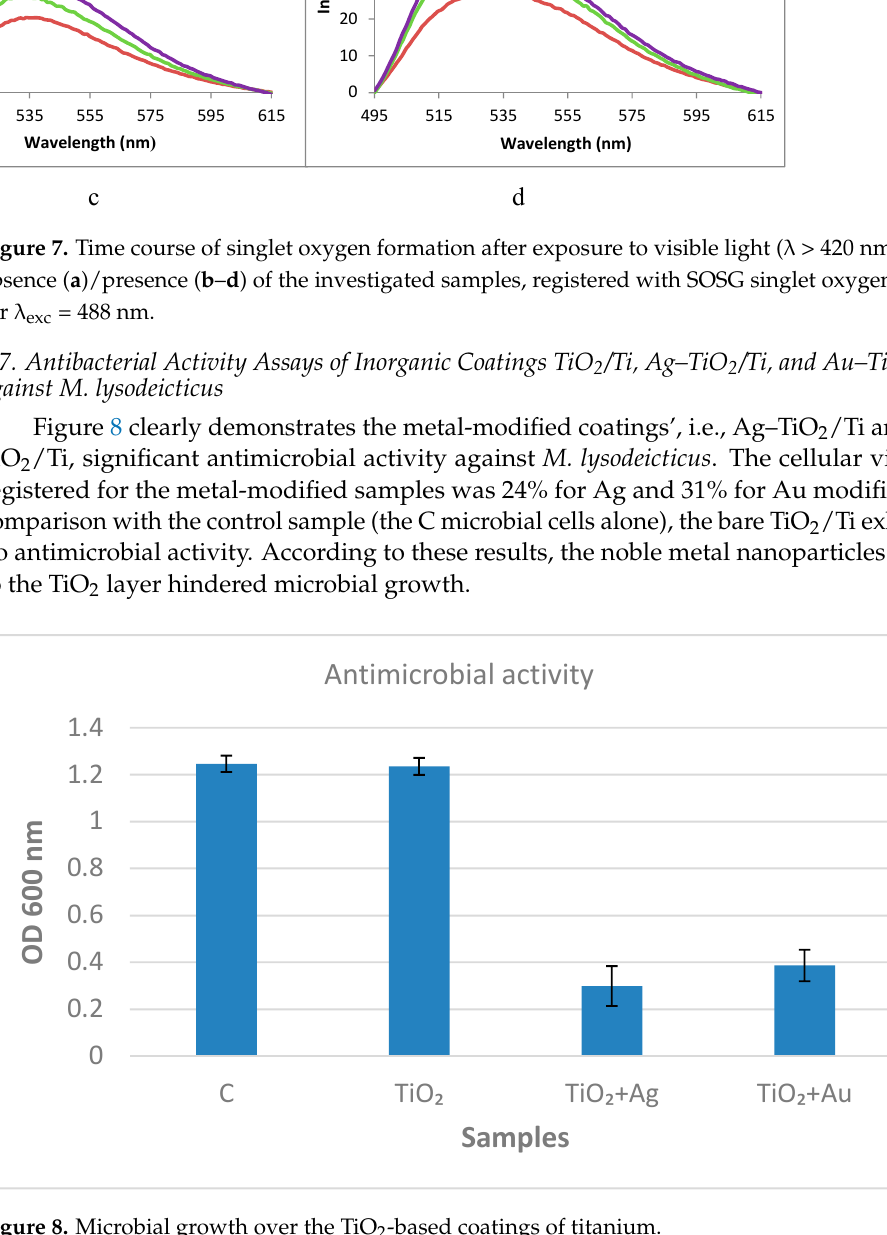
Figure 9. Activity of lysozyme (free and loaded on inorganic coatings) against M. lysodeicticus . The loaded lysozyme appears to have a slower reactivity than the free enzyme, but this is significant and clearly evidenced after 24 h (as compared with the blank test carried out with the M. lysodeikticus cell suspension alone). Based on Figure 9, the following